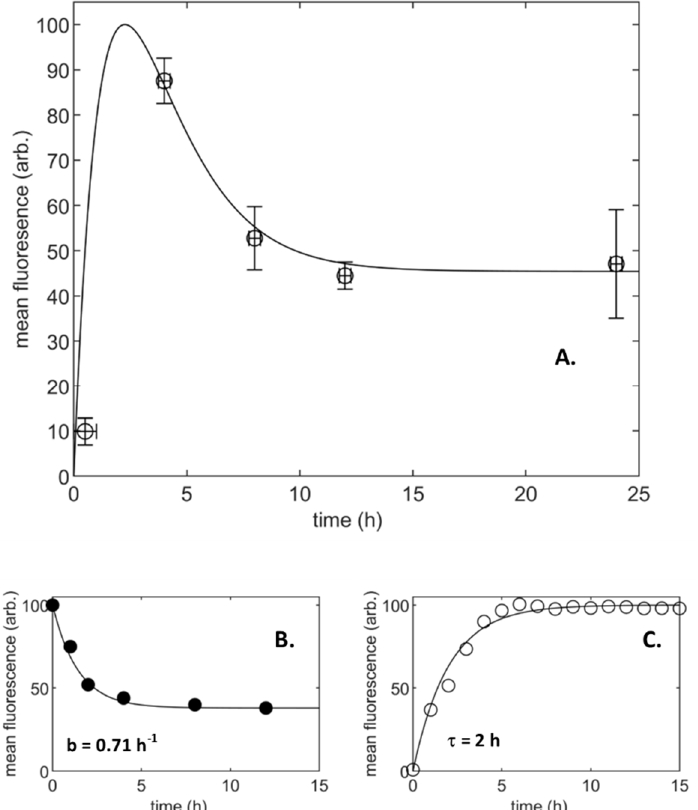
Figure 3. ( A ). Mean fluorescence per cell from dosing study with ND7/23, neuronal cells exposed to trimethyl chitosan (TMC16) nanoparticles (data from Gomes et al. [28], solid line: fit curve using the analytical function in Methods—A4, error bars indicate s.e.m.). ( B ). fluorescence from nanoparticles undergoing enzymatic degradation (data from Gomes et al. [28], solid line: e −bt fit curve). ( C ). accumulation of particle fluorescence signal from the base of the culture well (solid line: [1 − e −t/τ ] fit curve).